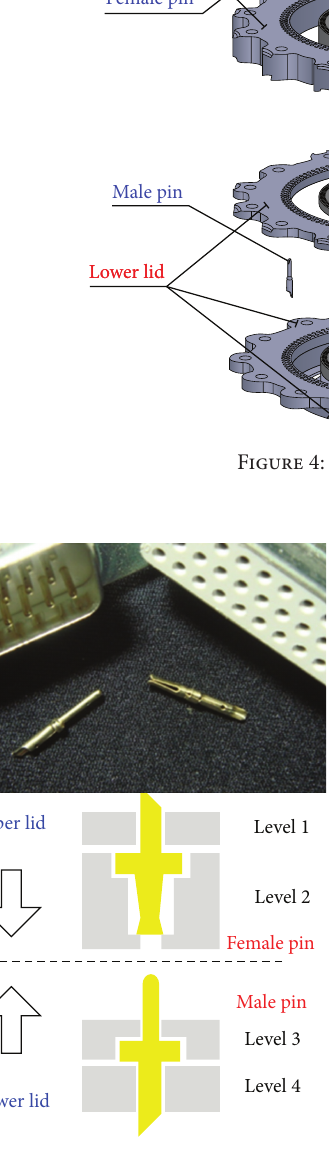
Figure 5: Contact is achieved using D-sub connector solder-type male/female pins.